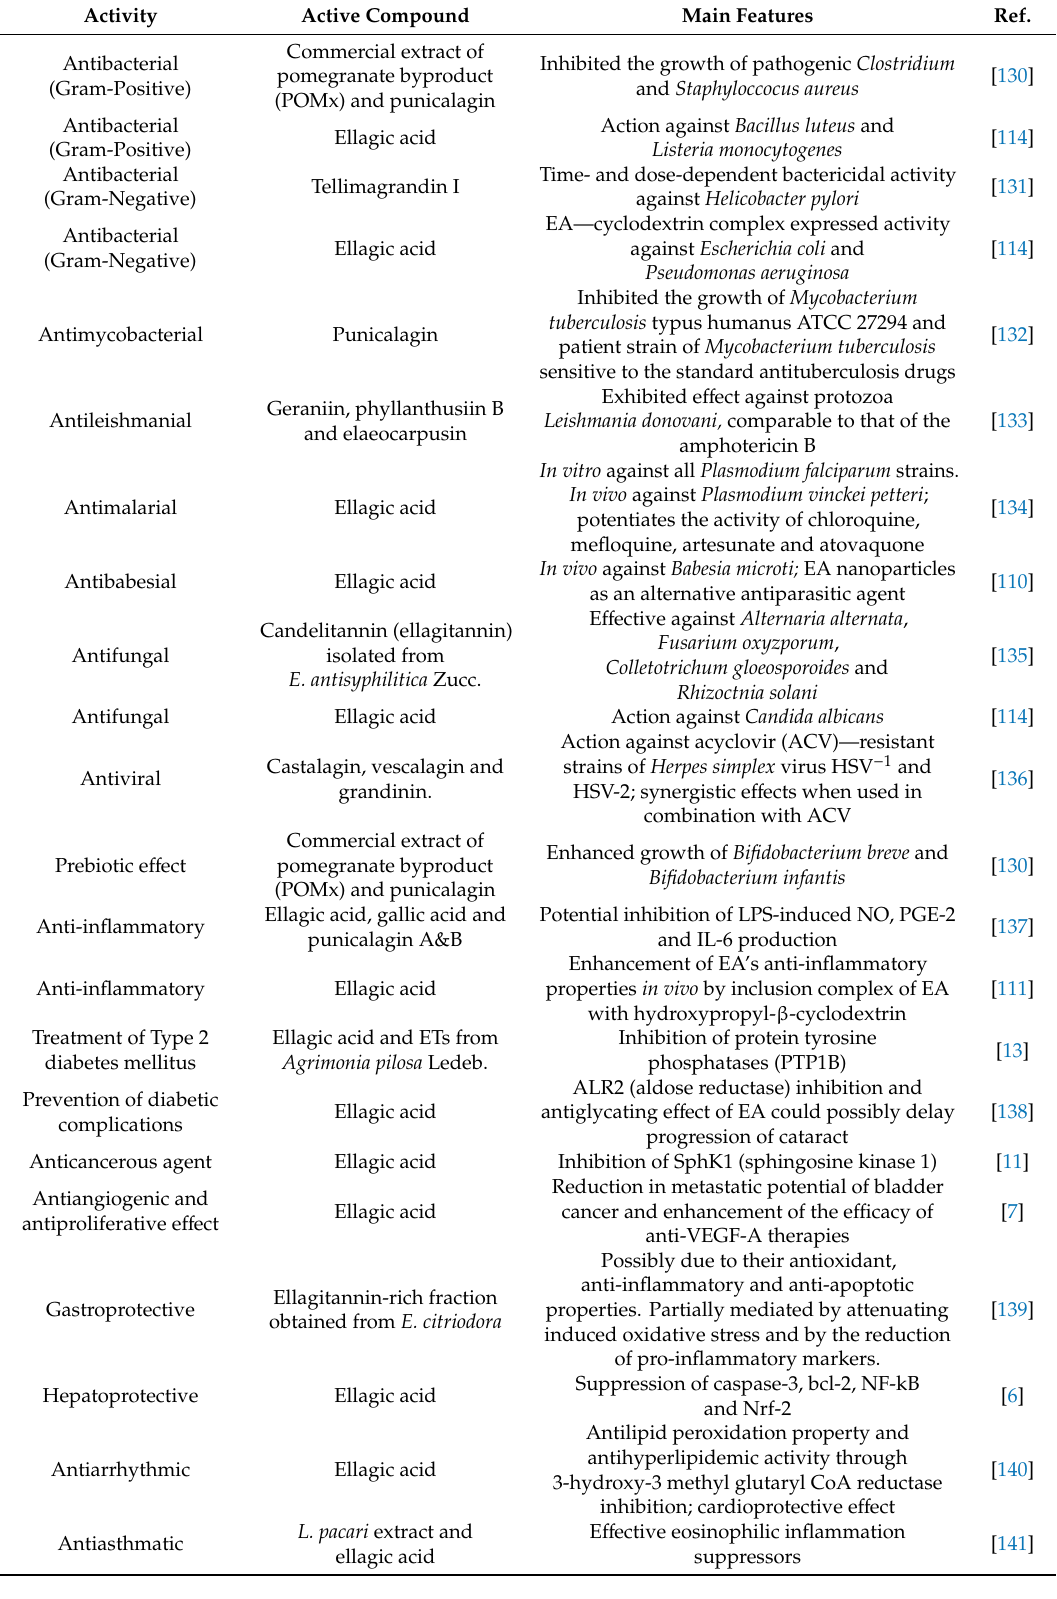
Table 2. Possible biological e ff ects of EA and its